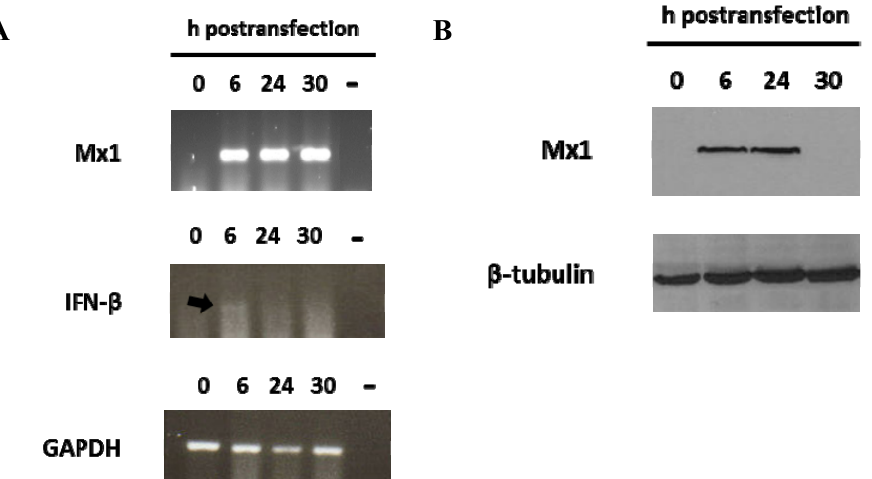
Figure 2. Mx1 induction in porcine cells transfected with the 3 ′ NCR RNA. SK6 cells (1 × 10 6 ) were transfected with 20 μ g/mL 3 ′ NCR transcripts. Cells were lysed at 0, 6, 24 or 30 h after transfection. ( A ) RT-PCR detection of IFN- β , Mx1 and GAPDH mRNAs in RNA extracted from SK6 lysates. Negative controls (water) were included in the RT-PCR assays; ( B ) Mx1 detection by immunoblot in transfected SK6 cells. Tubulin was used for normalization.